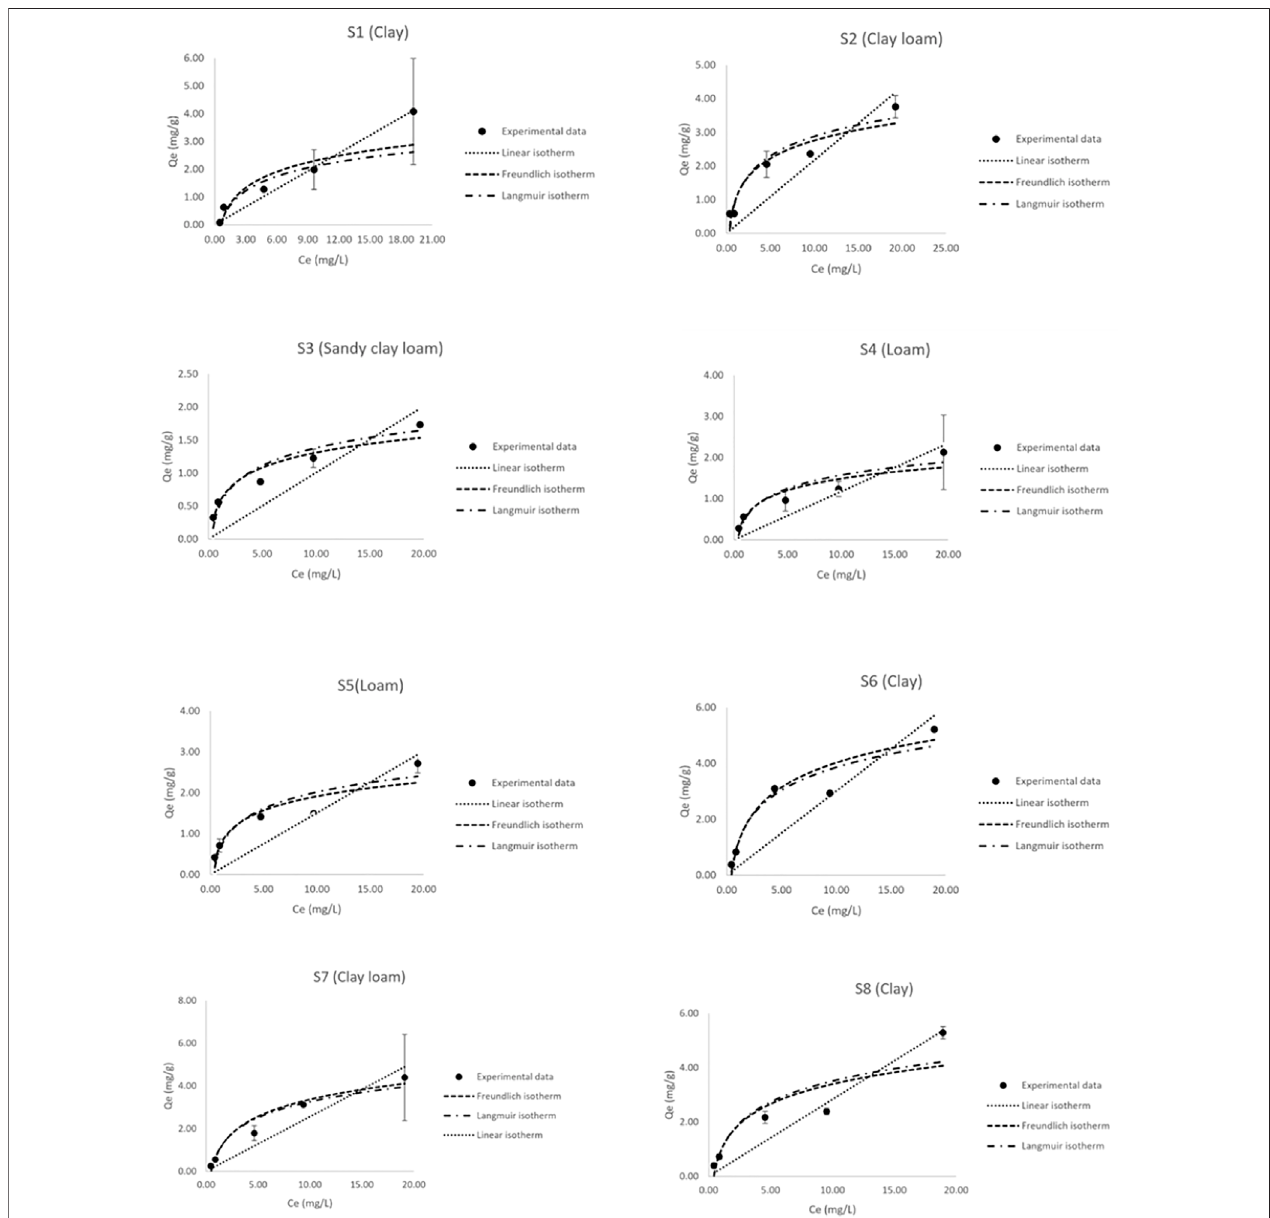
FIGURE 6 | The experimental data of the soil samples plotted with different fi tted sorption isotherms.